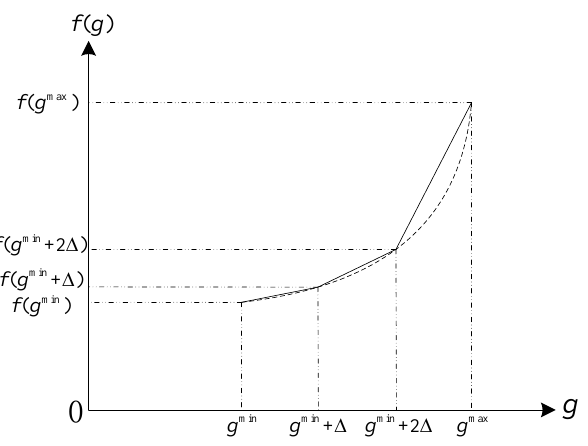
Figure 1. Liner processing of quadratic